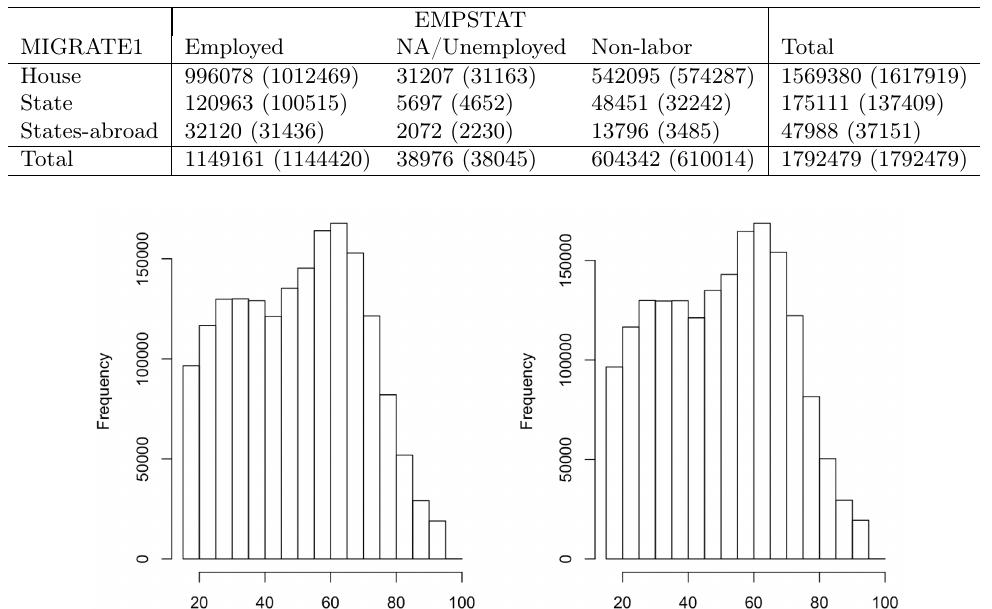
Figure 2. Histogram of the AGE variable in the American Community Survey data before and after